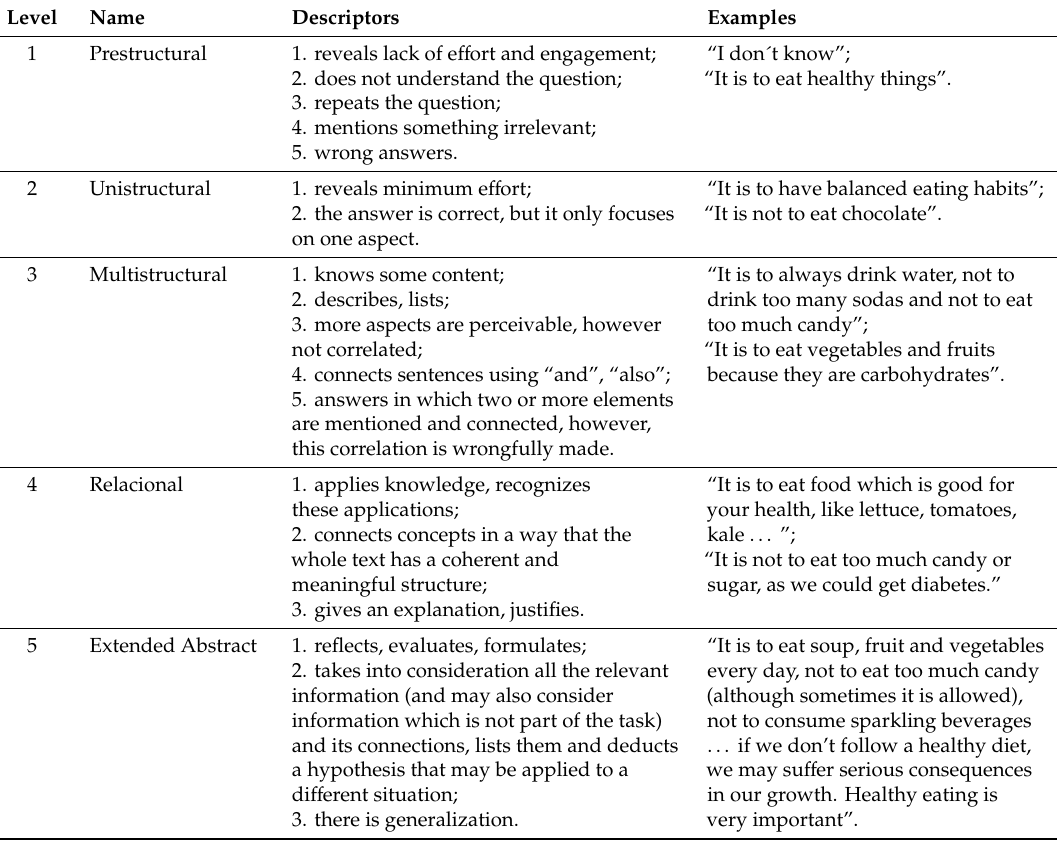
Table 1. SOLO coding criteria applied to complexity of knowledge about healthy